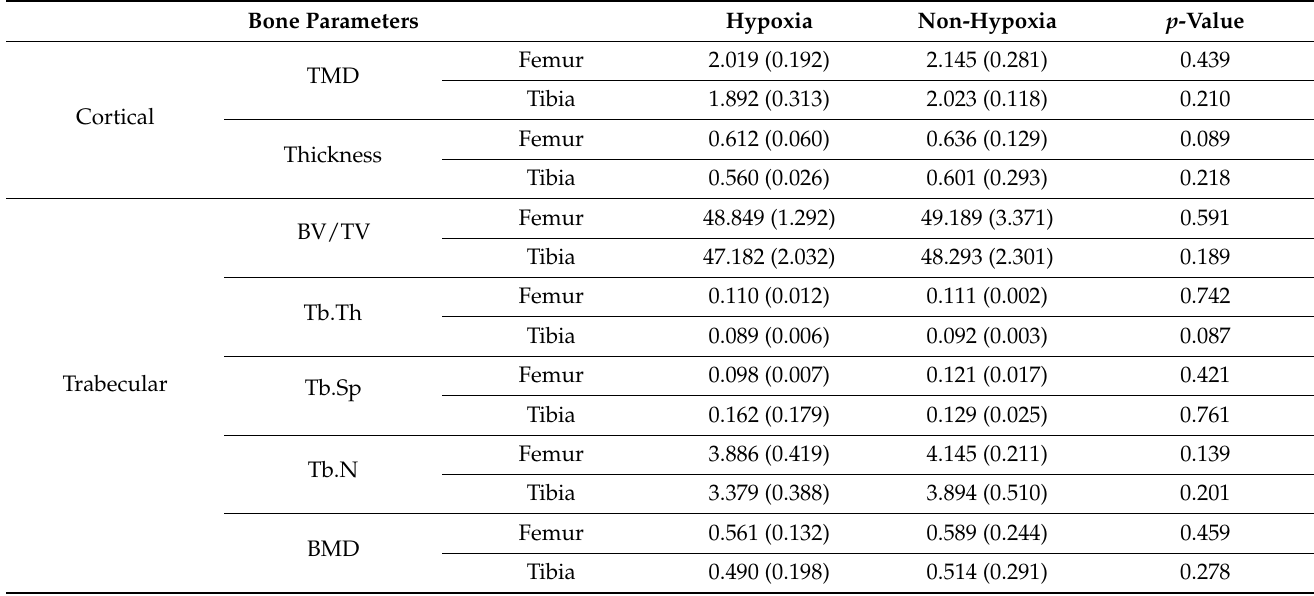
Table 2. Comparison of bone morphometry parameters between guinea pigs subject to hypoxia or not. Bone